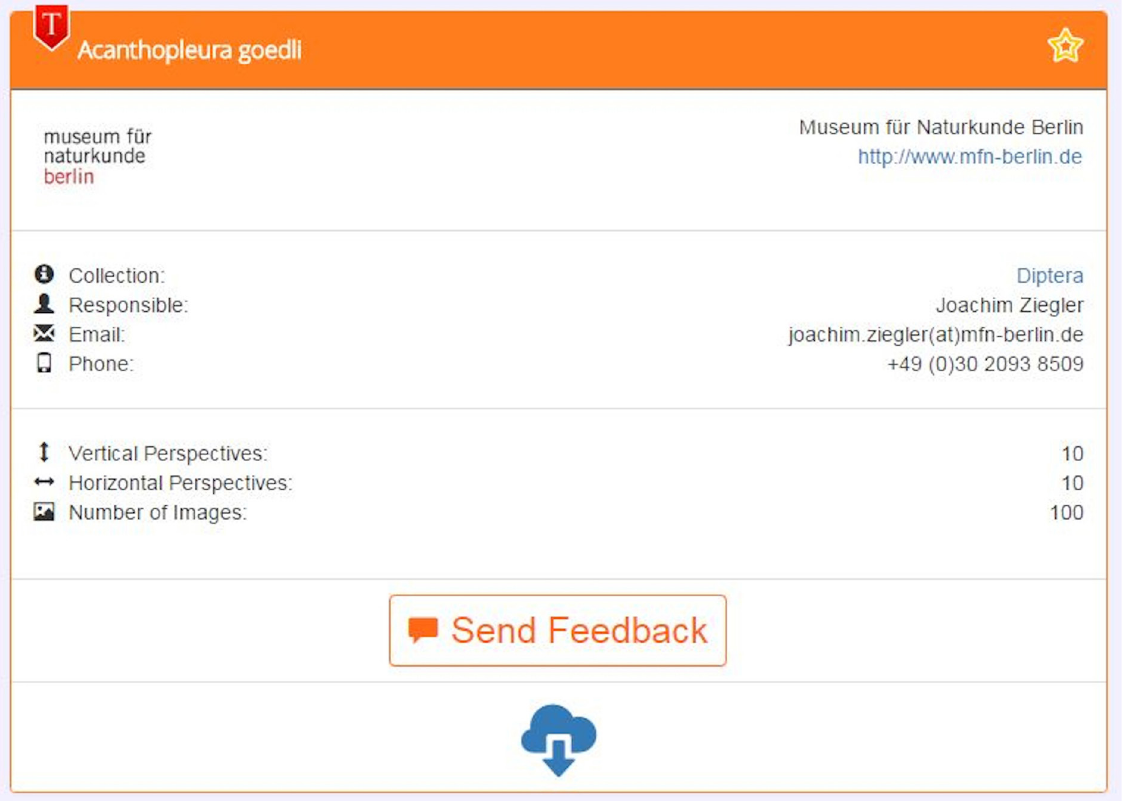
Fig. 2.22. Plane 1 of the specimen page at Zoosphere.net, showing the collections responsible and the acquisition metadata. Image copyright